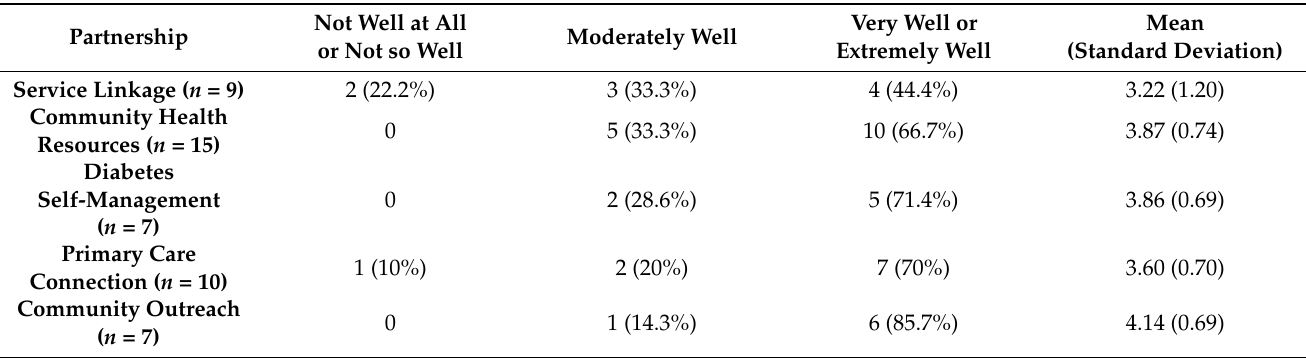
Table 4. Partnership-level assessment of the extent to which the goal of developing a meaningful partnership was achieved (reproduced from